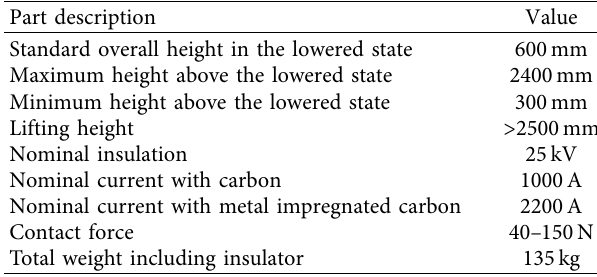
Figure 1: (a) Actual description of SSS87 pantograph [37]; (b) schematic description of SSS87 articulated pantograph model. Table 1: Technical data of SSS87 articulated pantograph